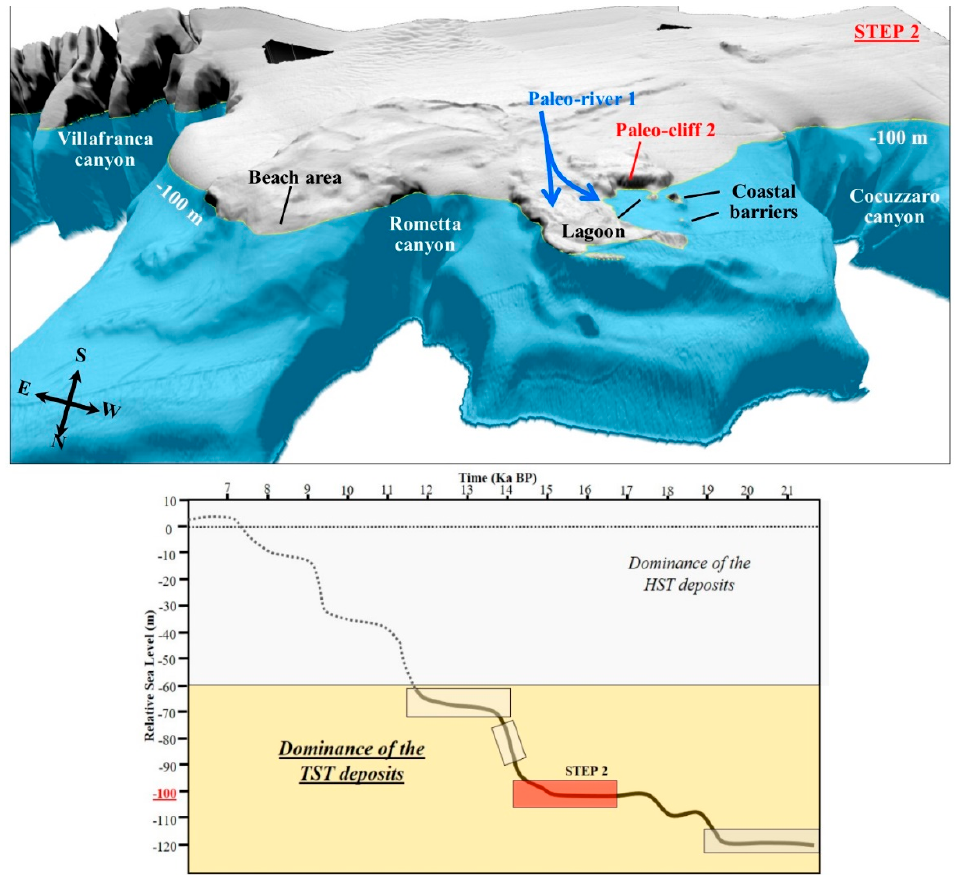
Figure 8. On the basis of a 3D bathymetric map, the reconstruction of the geomorphological evolution of past coastal systems of the area between the Cocuzzaro and Rometta canyons, simulating a sea level of − 100 m.